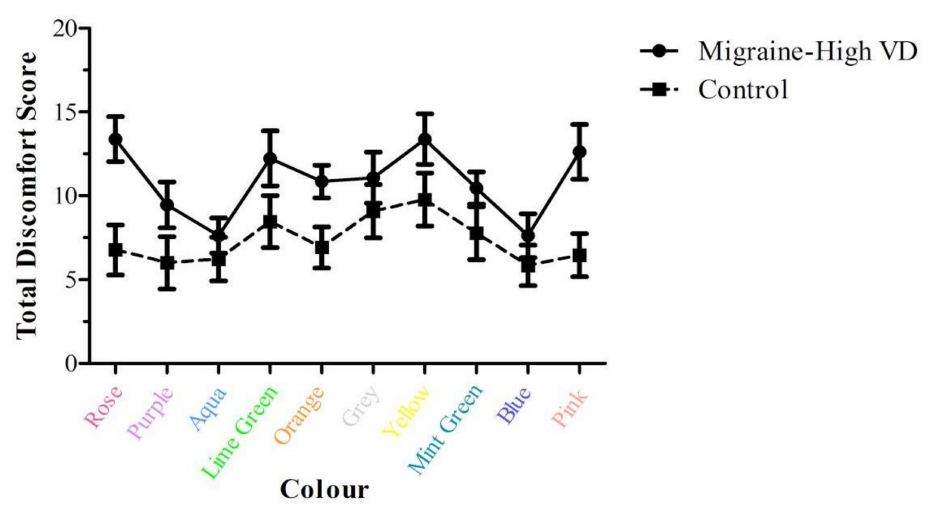
Figure 6. Total Discomfort score for each Group across the ten colours. The error bars represent ± 1 SEM (N = 26, 13 per group).